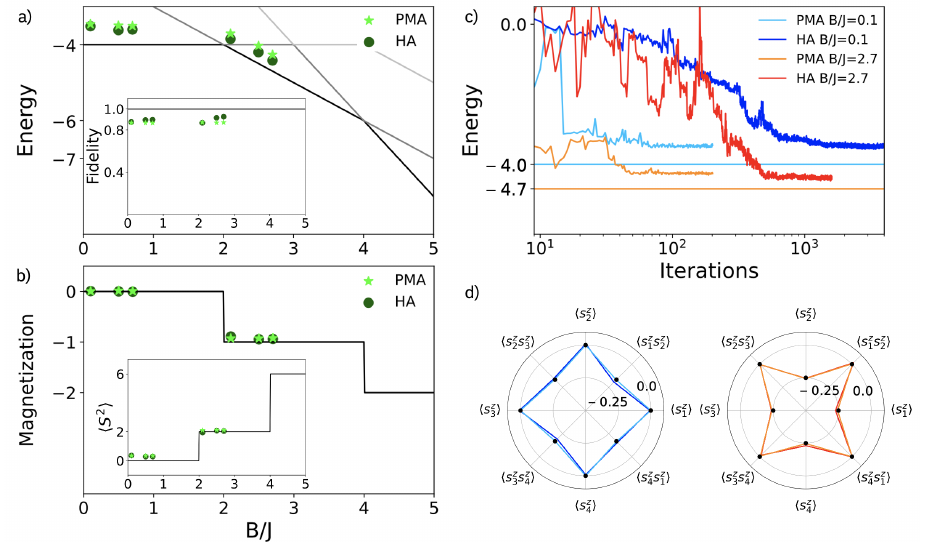
Figure 2. N = 4 spin ring noisy simulations, with a custom noise model derived from IBM Quantum chips with Quantum Volume 128. The VQE configuration in terms of maximum number of itera- tions and number of layers of the ansatzes reflects the configuration used for noiseless statevector calculations of Figure 1. ( a ) Ground state energy VQE results using heuristic (HA, dark-green) and Heisenberg (PMA, light-green) ansatzes for different values of B / J . Inset: related ground-state fi- delity. ( b ) Observables computed on the ground state computed by VQE: longitudinal magnetization M = ∑ i s z and total spin S 2 expectation value. Both ansatzes perform similarly in presence of noise. i ( c ) Ground state energy convergence as a function of VQE iterations for two different values of B / J , belonging to the two distinct regions: low B / J = 0.1 (blue-tones) and intermediate B / J = 2.7 (red- tones). SPSA has been used as classical optimizer. The horizontal lines indicate the exact solutions. Remarkably, PMA needs almost one order of magnitude less iterations to converge. ( d ) Expectation s z value of local spin observables s z and s z . The black dots indicate the exact solution. Radar plots i i i + 1 highlight that both ansatzes reconstruct the correct translational invariance of the target